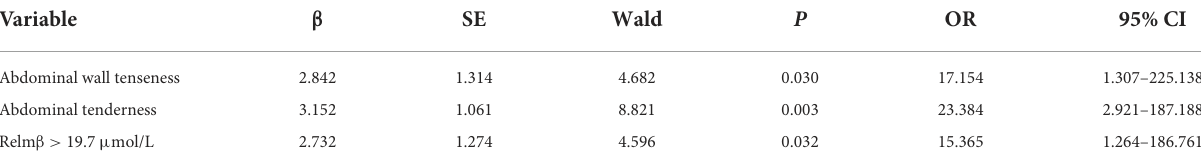
TABLE 3 Multivariate analysis of predictors of the surgical timing. Variable